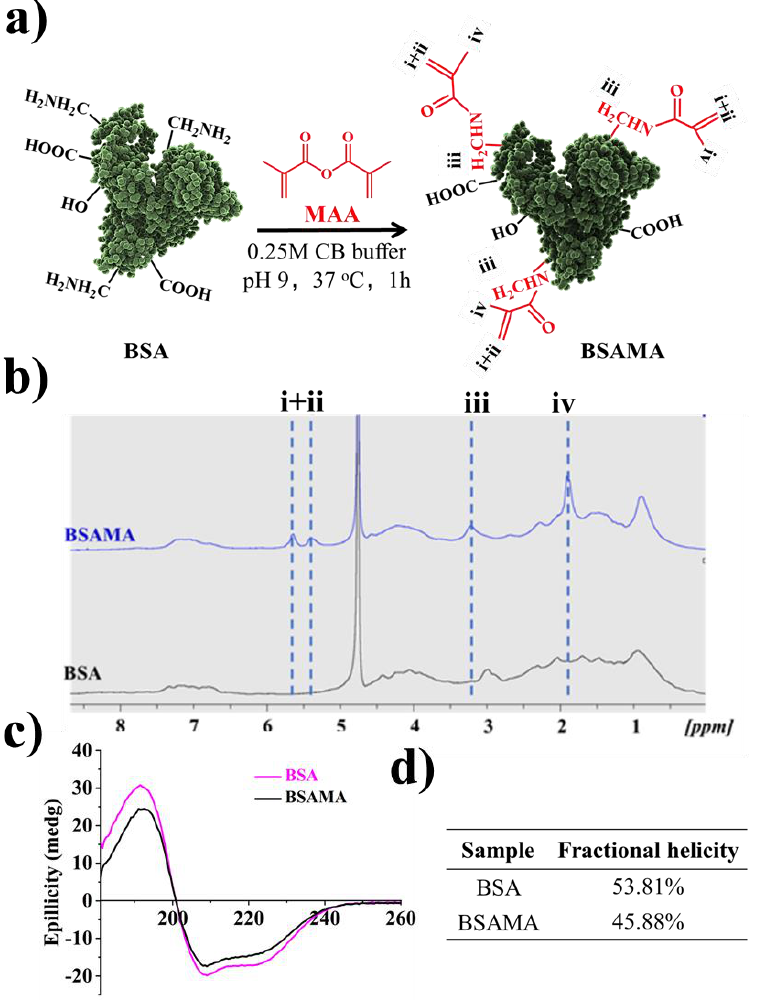
Figure 1. ( a ) Graphical illustration of the preparation of BSAMA. ( b ) 1 H-NMR characterization of BSA and BSAMA. ( c ) Circular Dichroism (CD). ( d ) Percent fractional helicity for BSA and